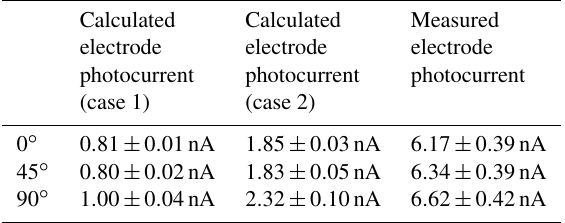
Table 2. Calculated electrode photocurrent based on the photodiode current from Table 1 and the base model from Sect. 2, compared to the experimentally measured electrode photocurrent, for each of the three inclination angles